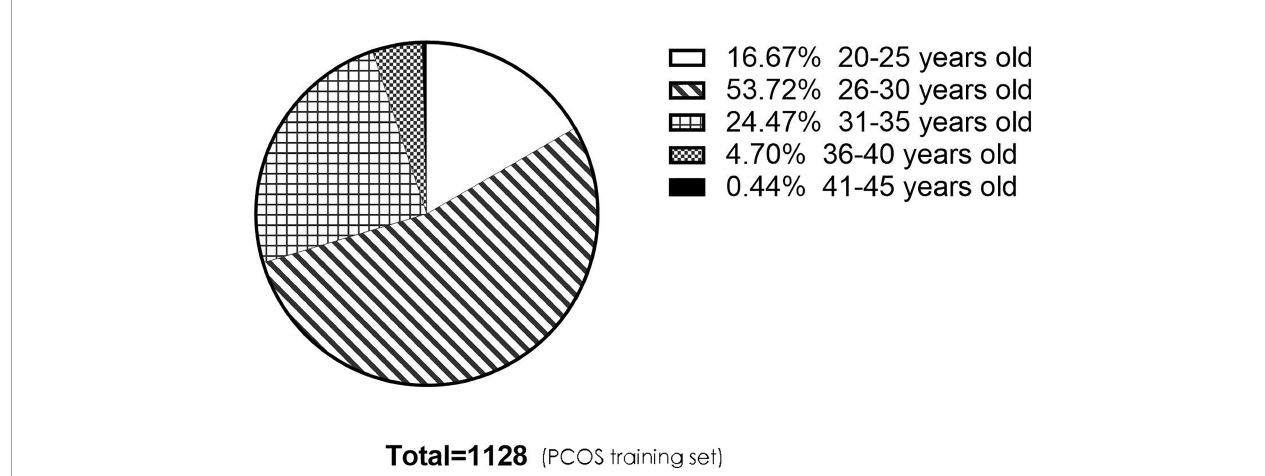
FIGURE 7 | The pie chart describes the age distribution of patients in the PCOS training set. There were 188 (16.67%), 606 (53.72%), 276 (24.47%), 53 (4.70%), and 5 (0.44%) people aged 20 – 25, 26 – 30, 31 – 35, 36 – 40, and 41 – 45, respectively. There were 1,070 people under the age of 35, accounting for 94.86%. PCOS, polycystic ovary